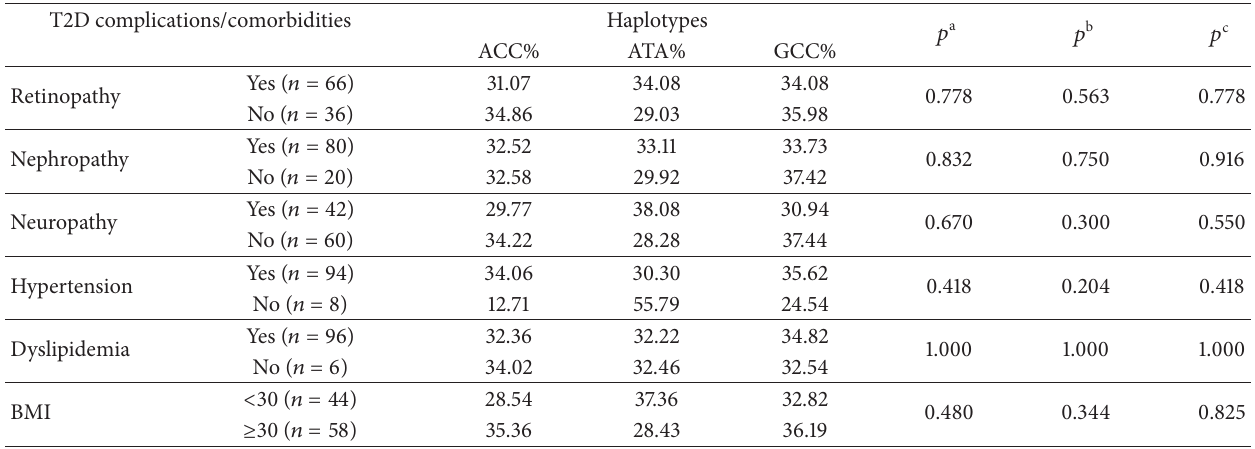
Table 4: Haplotype distribution of IL-10 promoter gene (-1082G/A, -819T/C, and -512C/A) in T2D patients considering complications and